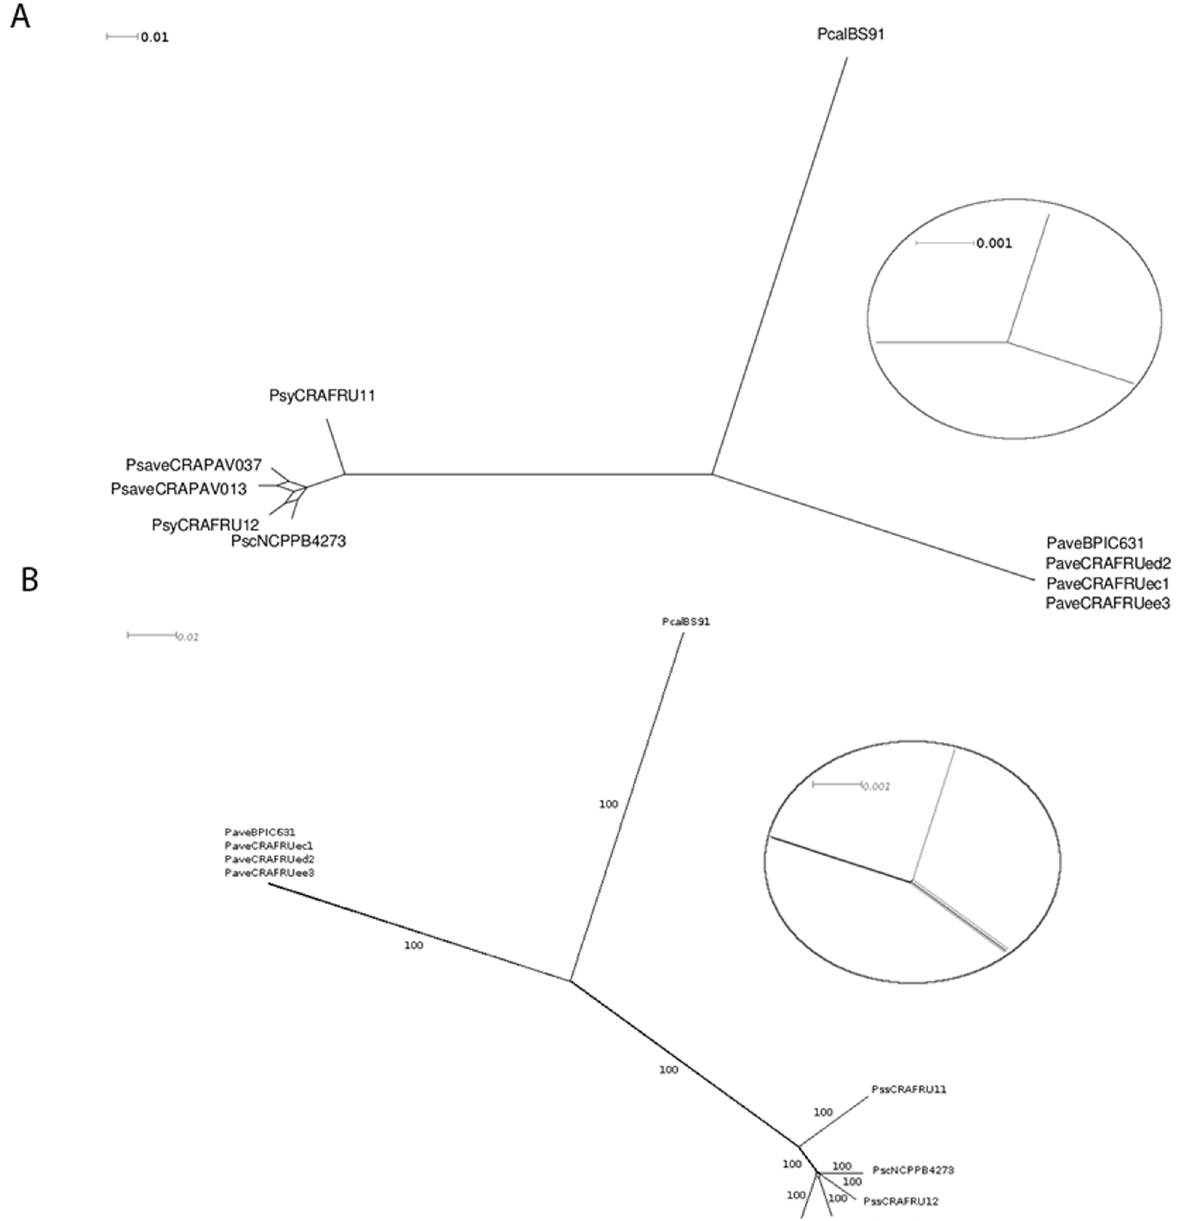
Fig 2. Split consensus network obtained from 2.812 trees for the nine pseudomonad strains infecting Corylus avellana . A. The tree has a cut-off value of 0.19. The scale bar indicates the number of substitutions per nucleotide position. Strain legend is shown in Table 1. No reticulation was observed between the Pseudomonas avellanae and P . syringae pathovar strains. B . Neighbor-net tree obtained from 2.812 core gene sequence alignments. The dendrogram (i.e., a total of 1.977.984 nucleotides) regards the nine pseudomonad strains infecting Corylus avellana trees. The scale bar indicates the number of substitutions per nucleotide position. Bootstrap values are shown at the main nodes. No reticulation was observed between the Pseudomonas avellanae and P . syringae pathovar strains. In both trees, P . cannabina pv. alisalensis Pcal BS91 was included in the analysis as outgroup. Strain legend is shown in Table